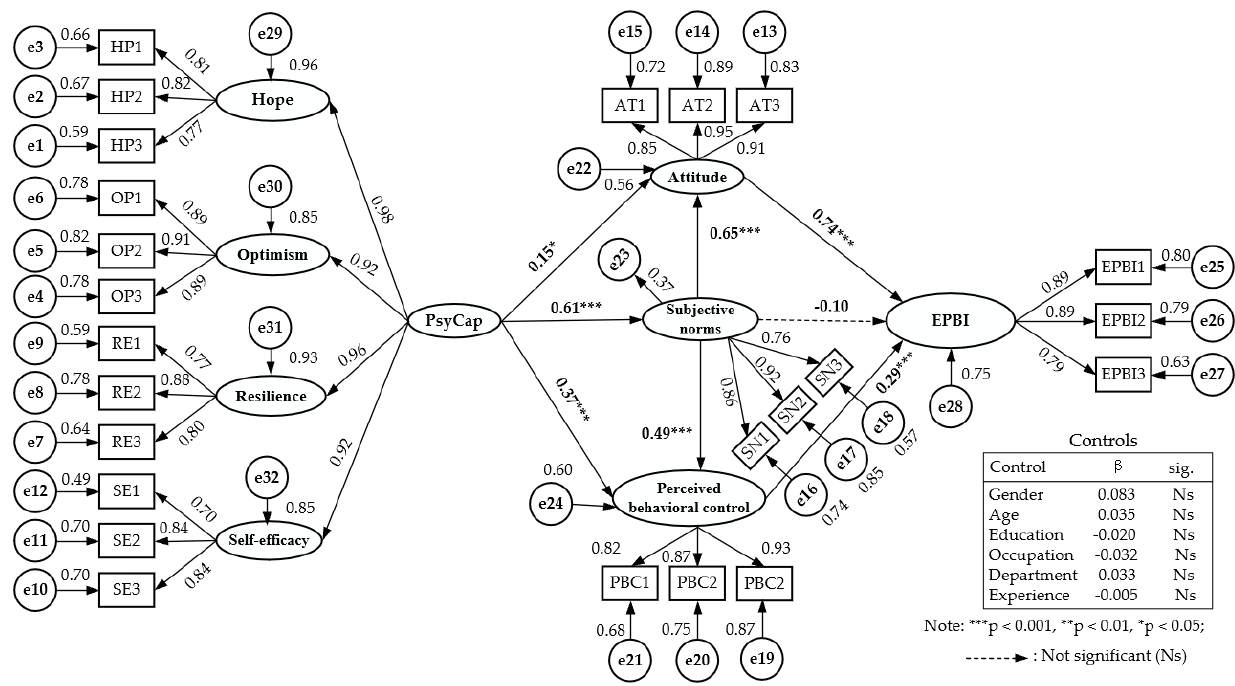
Figure 2. Structural equation model diagram of the influence of PsyCap on EPBI. Table 5. Path coefficient estimation and hyp othesis test of the mode l.